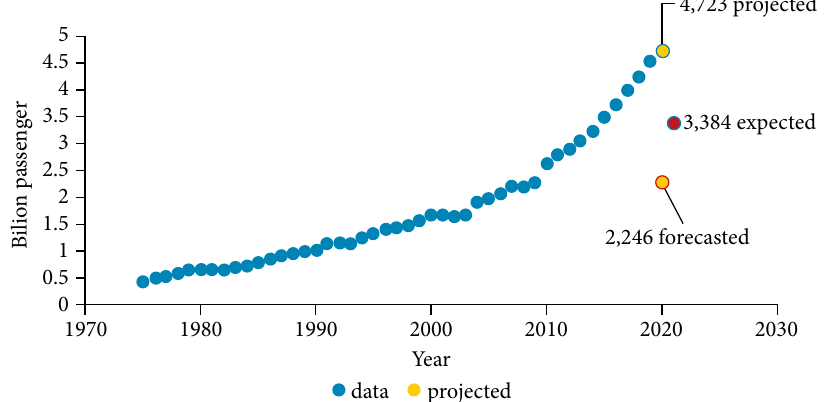
Figure 1. Yearly number of passengers carried globally according to the World Bank and IATA. The upper orange dot indicates the projected number pre-Covid-19, and the red dot exhibits the expected number for 2021, according to a relatively optimistic scenario. The lower orange dot indicates a probable (but optimistic) projection for 2020. The upper orange dot for 2020 indicates the projected numbers of passengers, a forecast based on a supposed growth of at